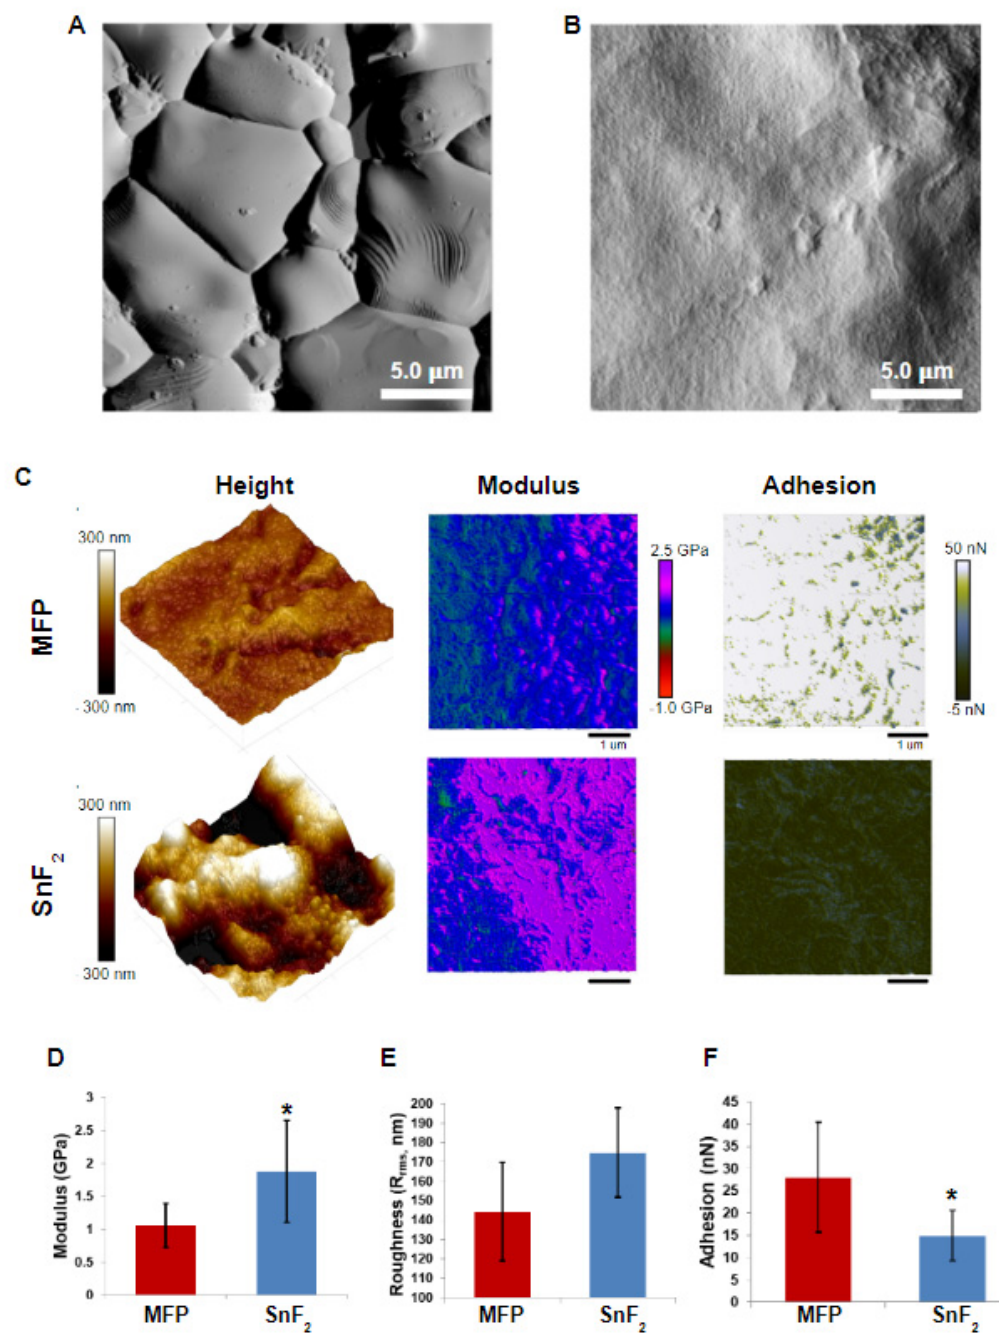
Figure 4. AFM images and quantification. PeakForce Error Images (25 µm × 25 µm) showing the surface of the hydroxyapatite (HAP) disc before ( A ) and after ( B ) biofilm growth. ( C ) HAP disc and biofilm height (left), qualitative modulus map (center) and qualitative adhesion map (right) for sodiummonofluorophosphate (MFP) (top) and SnF 2 (bottom) biofilms. ( D – F ) Barplots showing quantitative comparison of Young’s modulus, root mean square height (roughness), and adhesion of MFP and SnF 2 biofilms. All grouping information was calculated using Tukey method and 95% confidence interval, with asterisks indicating statistical significance with p < 0.05.